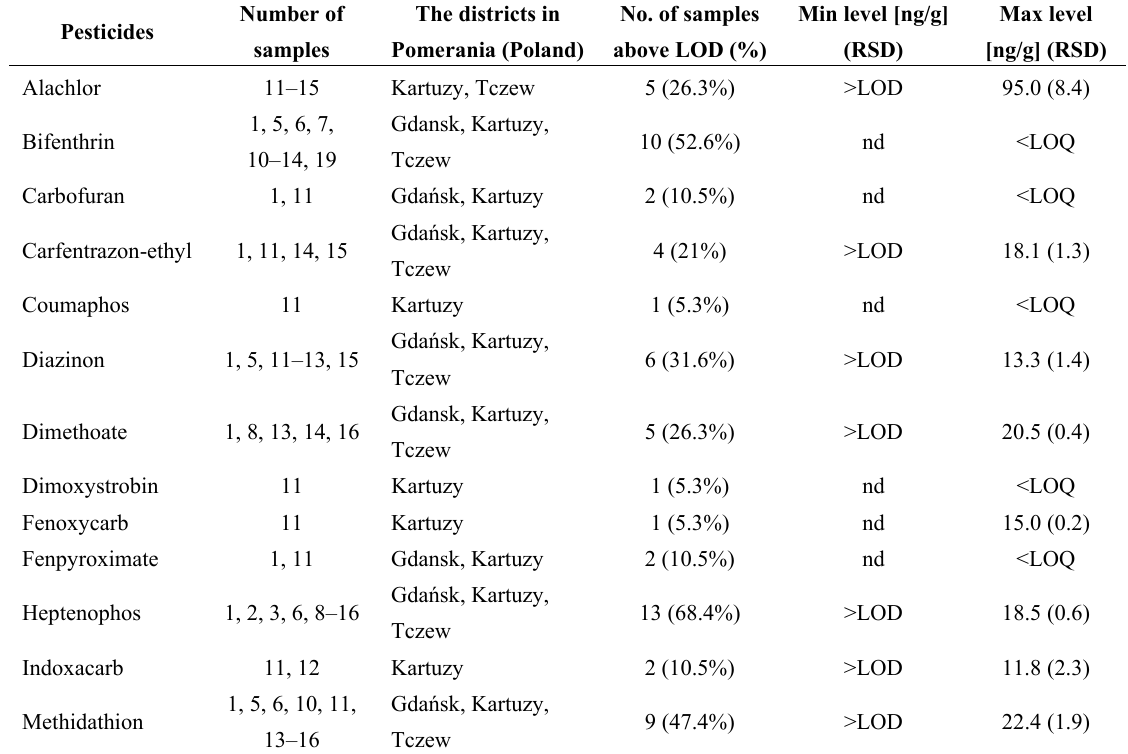
Table 2. Pesticide residues determined in honeybee samples collected from apiaries in the Pomerania region of Poland (concentration with expanded